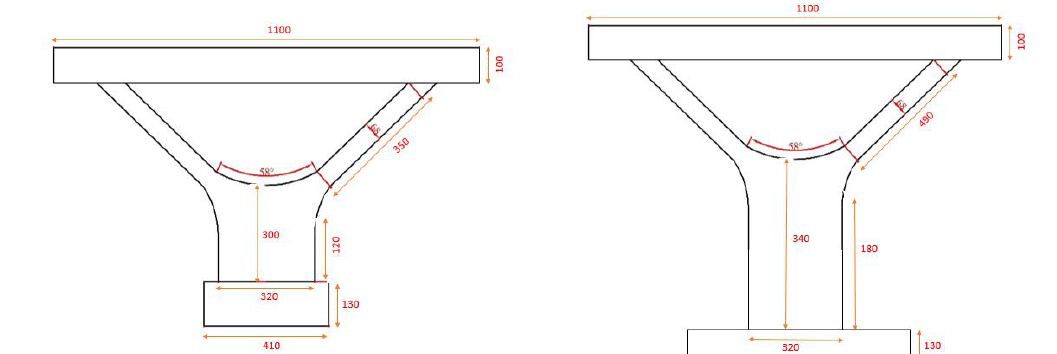
Fig. 1. Overview of the investigated bridge Columns Height 6, 8 meter.